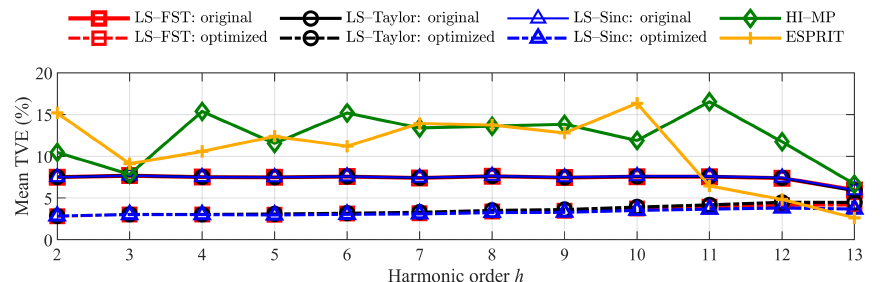
Figure 9. The mean TVE of LS-FST, LS-Taylor, and LS-Sinc with and without the proposed optimiza- tion, as well as the HI-MP and ESPRIT methods under harmonic frequency deviation test.